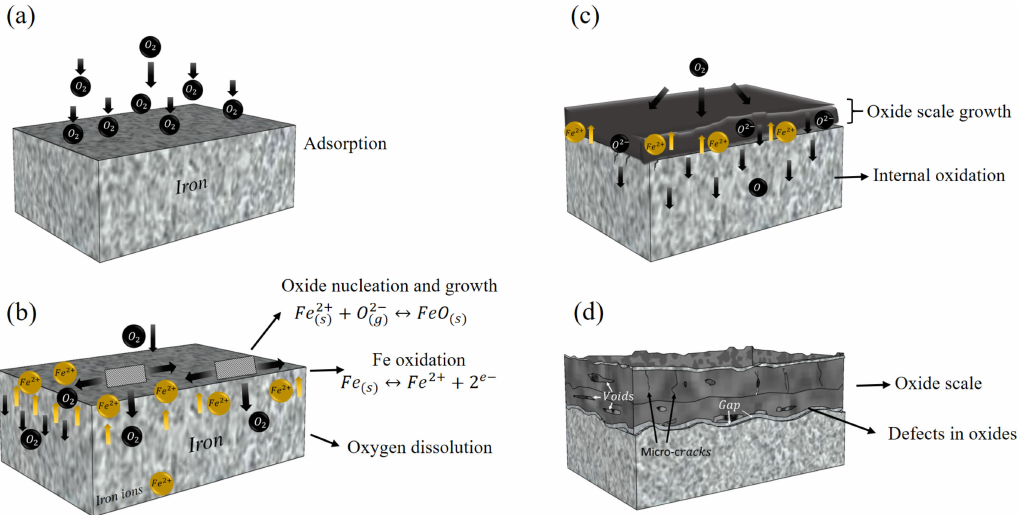
Figure 2. Schematic representation of oxidation phenomena occurring on a metal substrate by ( a ) the adsorption of oxygen resulting in oxide scales formed by ( b ) nucleation and ( c ) growth with the presence of ( d )